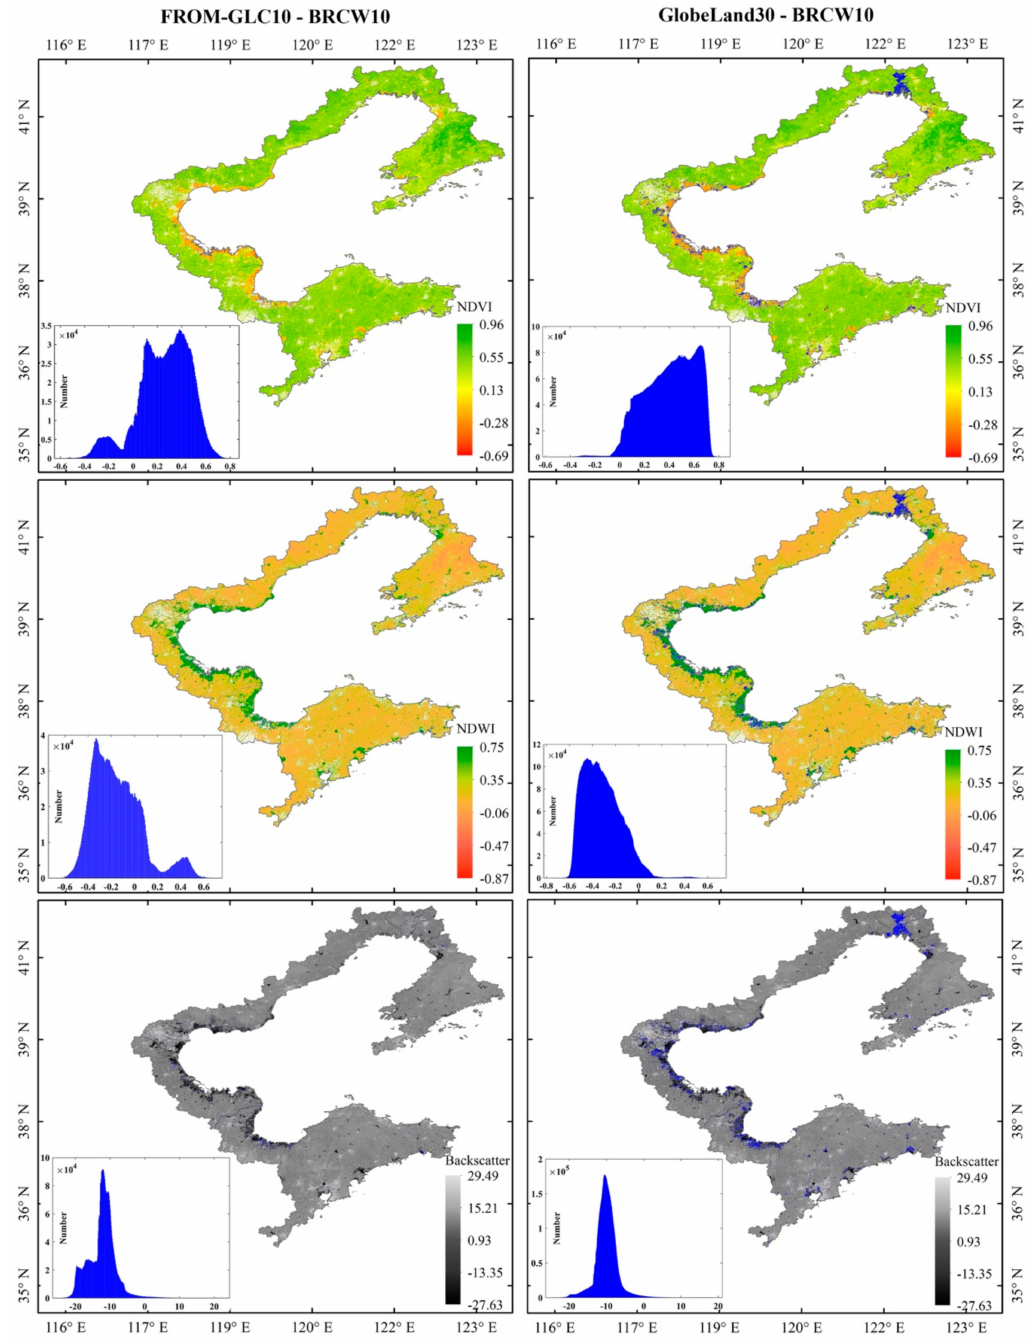
Figure 10. Spatial and frequency distributions of the NDVI, NDWI, and VV pixels that were wetland in the FROM-GLC10 (left column) and in the GlobLand30 wetland maps (right column) but not in the BRCW10 wetland